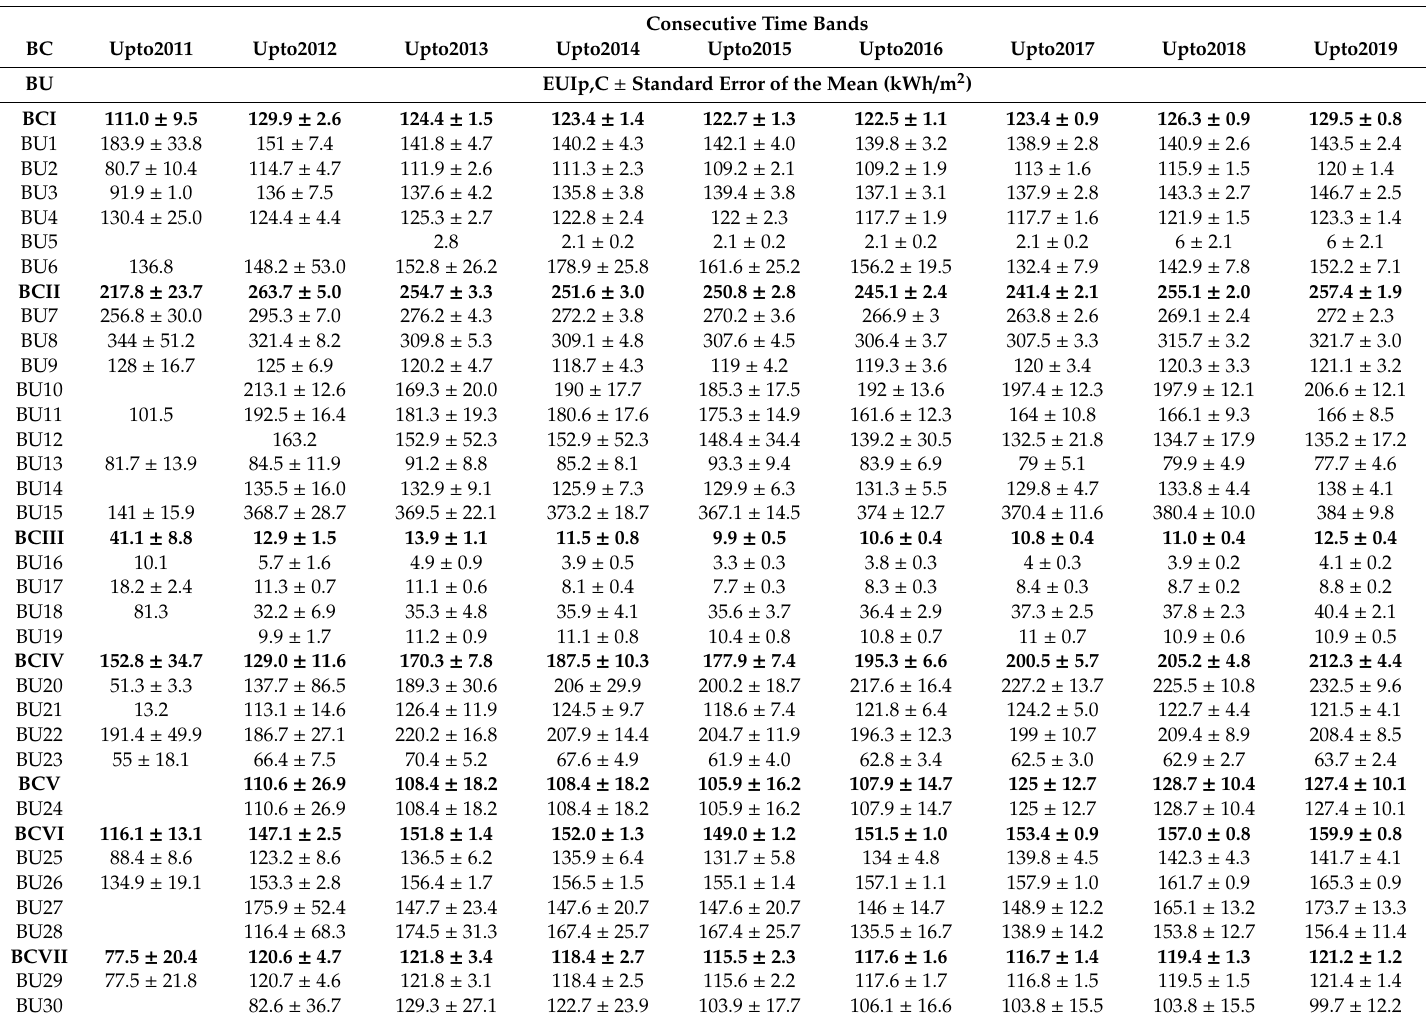
Table 4. Time evolution of calculated average primary energy use for space cooling for the di ff erent building categories and building uses in the NR